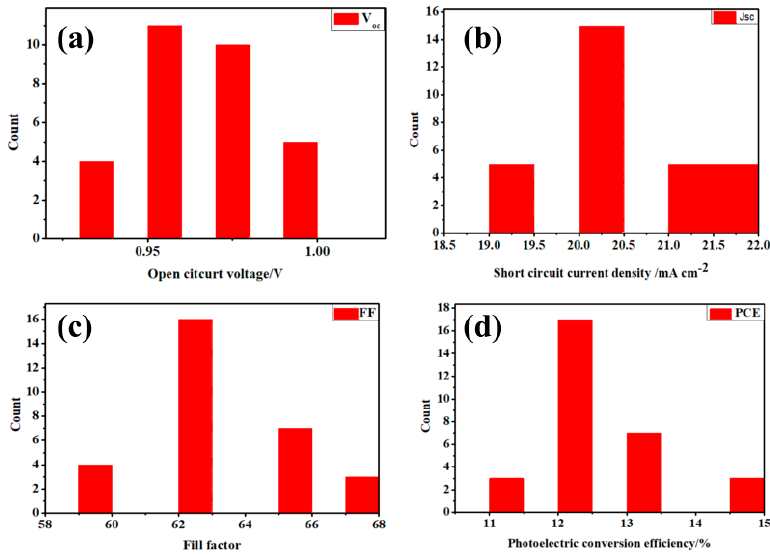
Figure 8. Histograms of ( a ) Voc, ( b ) Jsc, ( c ) FF, and ( d ) PCE of 30 PSCs based on SnO 2 HBL reactive sputtering.